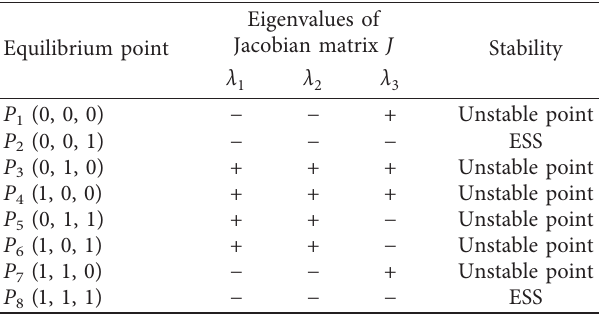
Table 5: Local stability of each equilibrium point based on case